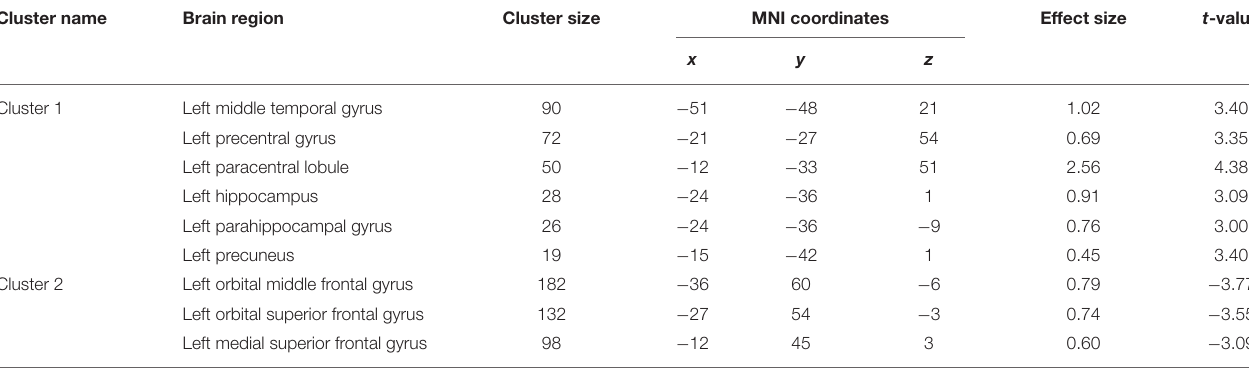
TABLE 3 | Regions showing significant difference in ALFF analysis between Group C and Group I at 7 days after surgery. Cluster